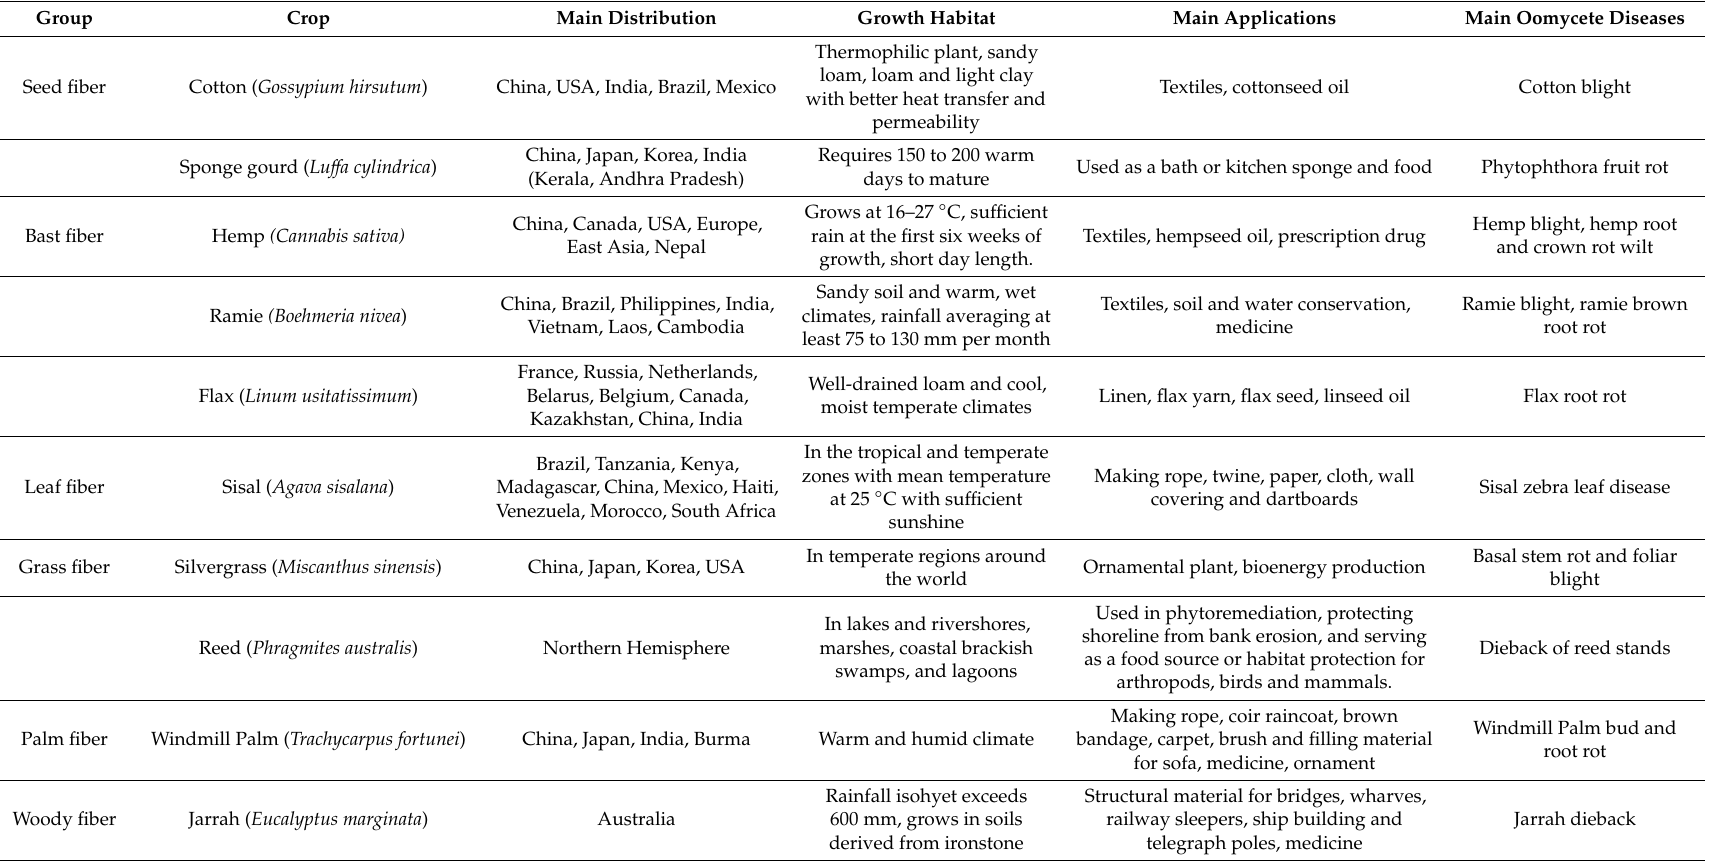
Table 1. Major types of commercial fiber crops and their distributions around the